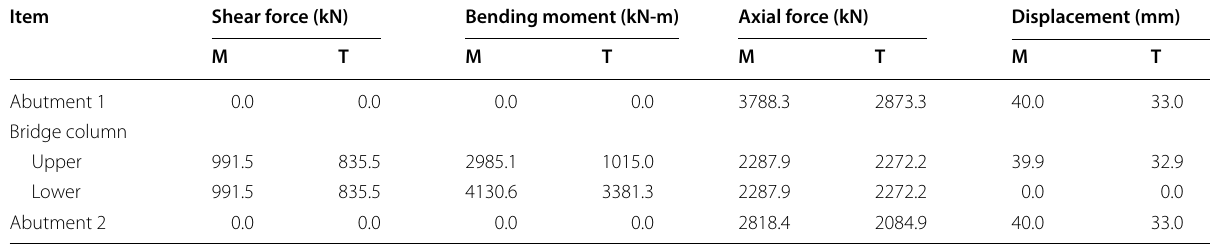
M Multi-model spectrum analysis, T Time-history